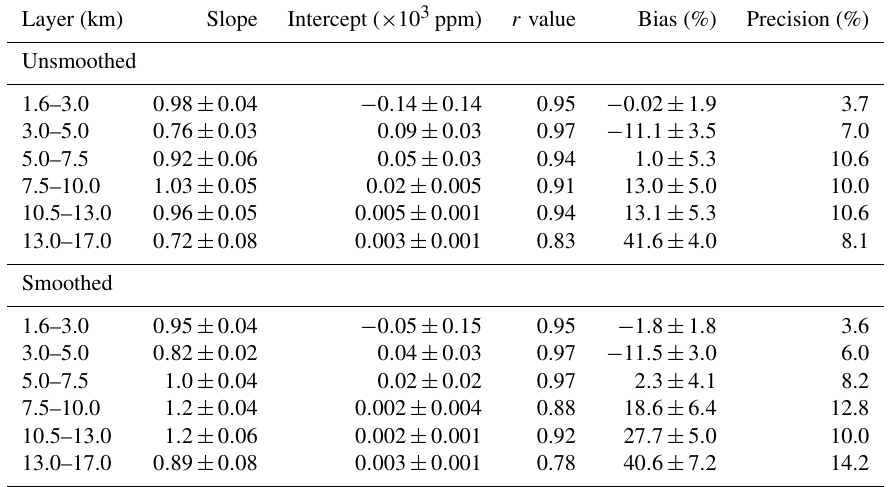
Table 2. Summary of the ODR and statistical analysis using ERA-6 at BLD. Results for unsmoothed (upper level) and smoothed (lower level) FPH comparisons are shown.